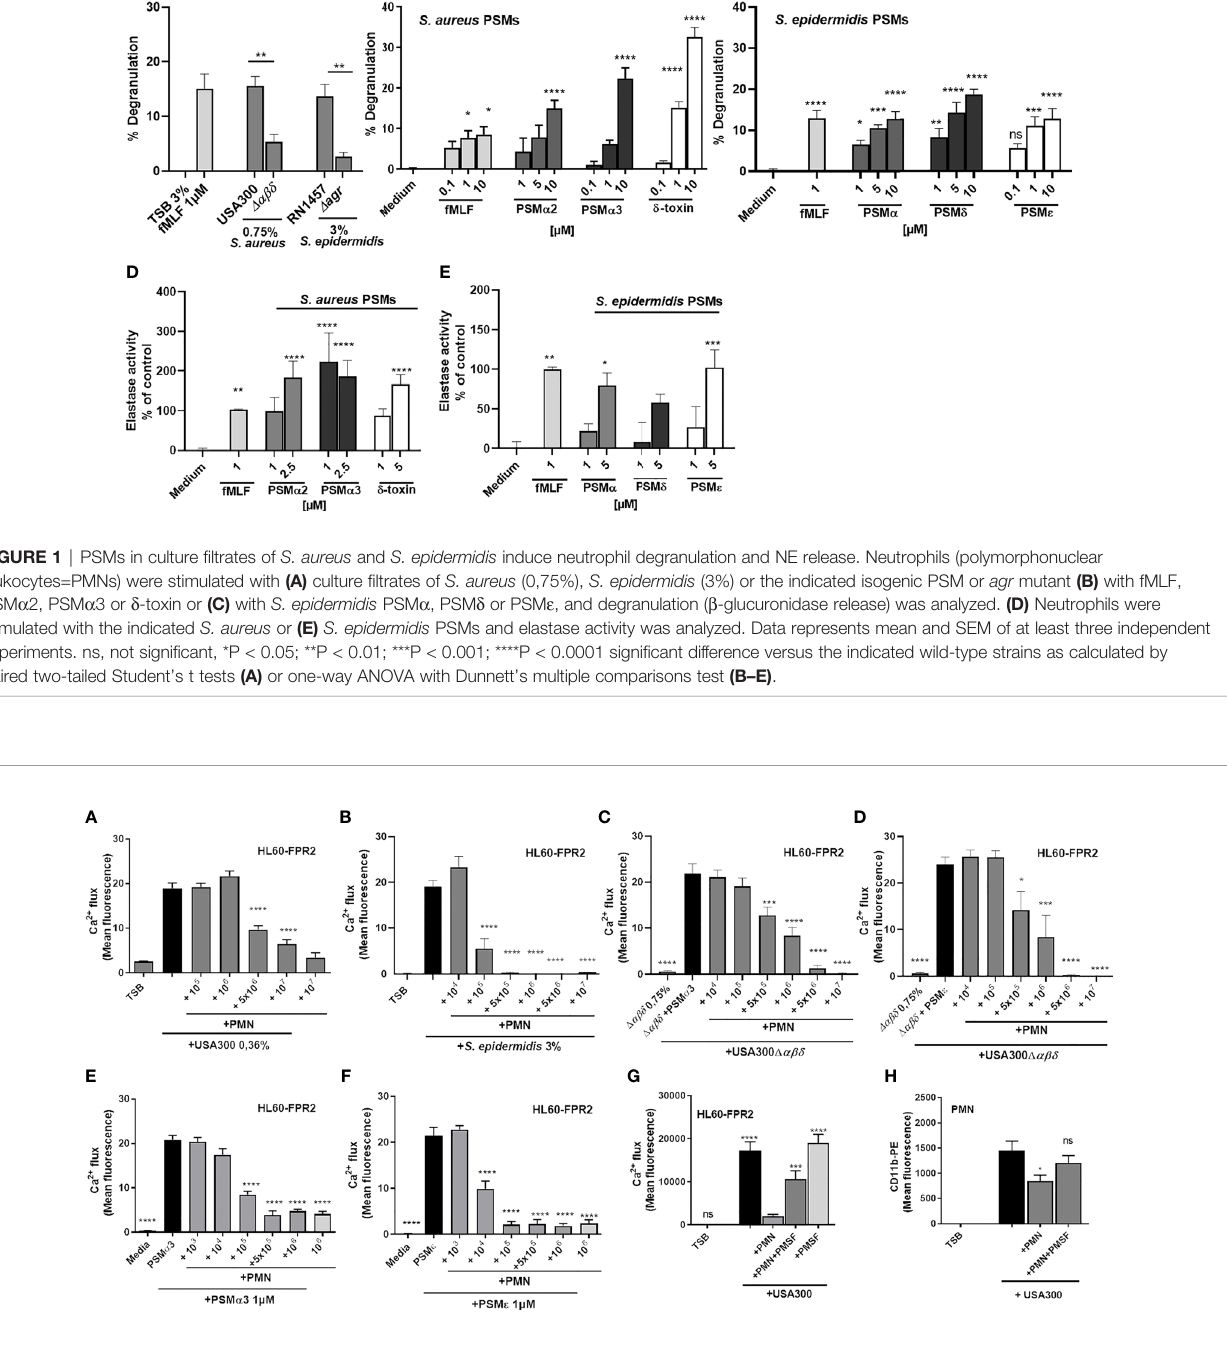
FIGURE 2 | Neutrophils inactivate PSM-mediated FPR2 activity of culture fi ltrates by NSPs. Culture fi ltrates of S. aureus USA300 (A) or S. epidermidis RN1457 (B) were incubated for six hours with increasing amounts of neutrophils. FPR2 transfected HL60 were stimulated with these treated culture fi ltrates and FPR2 activity was analyzed. PSM a 3 (C) or PSM e (D) were incubated with neutrophils. FPR2 transfected HL60 were stimulated with these supernatants and PSM activity was analyzed. Addition of PSM a 3 (E) or PSM e (F) to culture fi ltrates of a S. aureus PSM mutant induces FPR2 activation, an effect that can be dose-dependently inactivated by increasing amounts of neutrophils. Preincubation of neutrophils with the NSP inhibitor PMSF prevents inactivation of FPR2 activity (G) or CD11b upregulation by culture fi ltrates (H) . Data represents mean and SEM of at least three independent experiments. ns, not signi fi cant, *P < 0.05; ***P < 0.001; ****P < 0.0001 signi fi cant difference versus the indicated untreated control (A – F, H) or the neutrophil-treated control (G) as calculated by one-way ANOVA with Dunnett ’ s multiple comparisons test (A – H) .